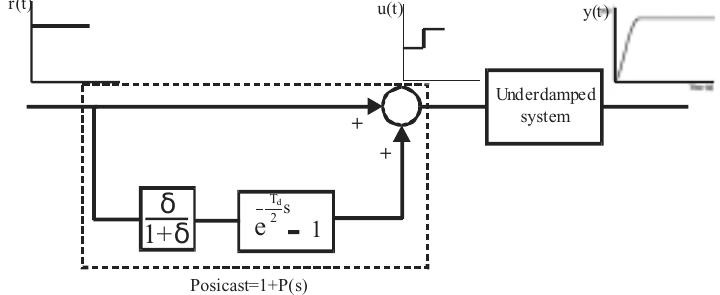
Fig. 3. The posicast feedforward control originally proposed by O.J.M